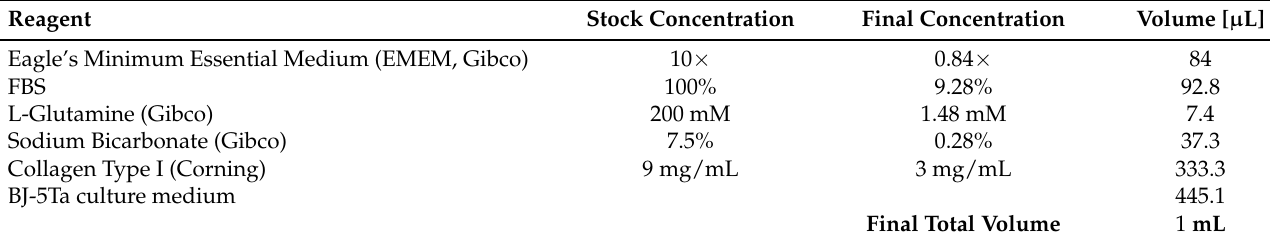
Table 1. Reagents and concentrations to prepare collagen